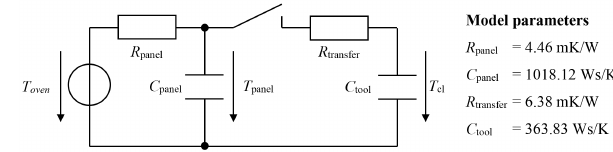
Figure 11. Equivalent thermal